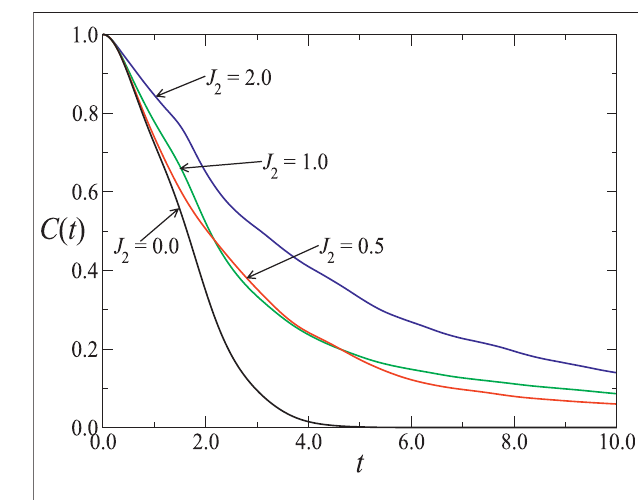
FIGURE3| Time-dependentcorrelation functionfor B (cid:2) 0 . 5and several values of the NNN coupling J 2